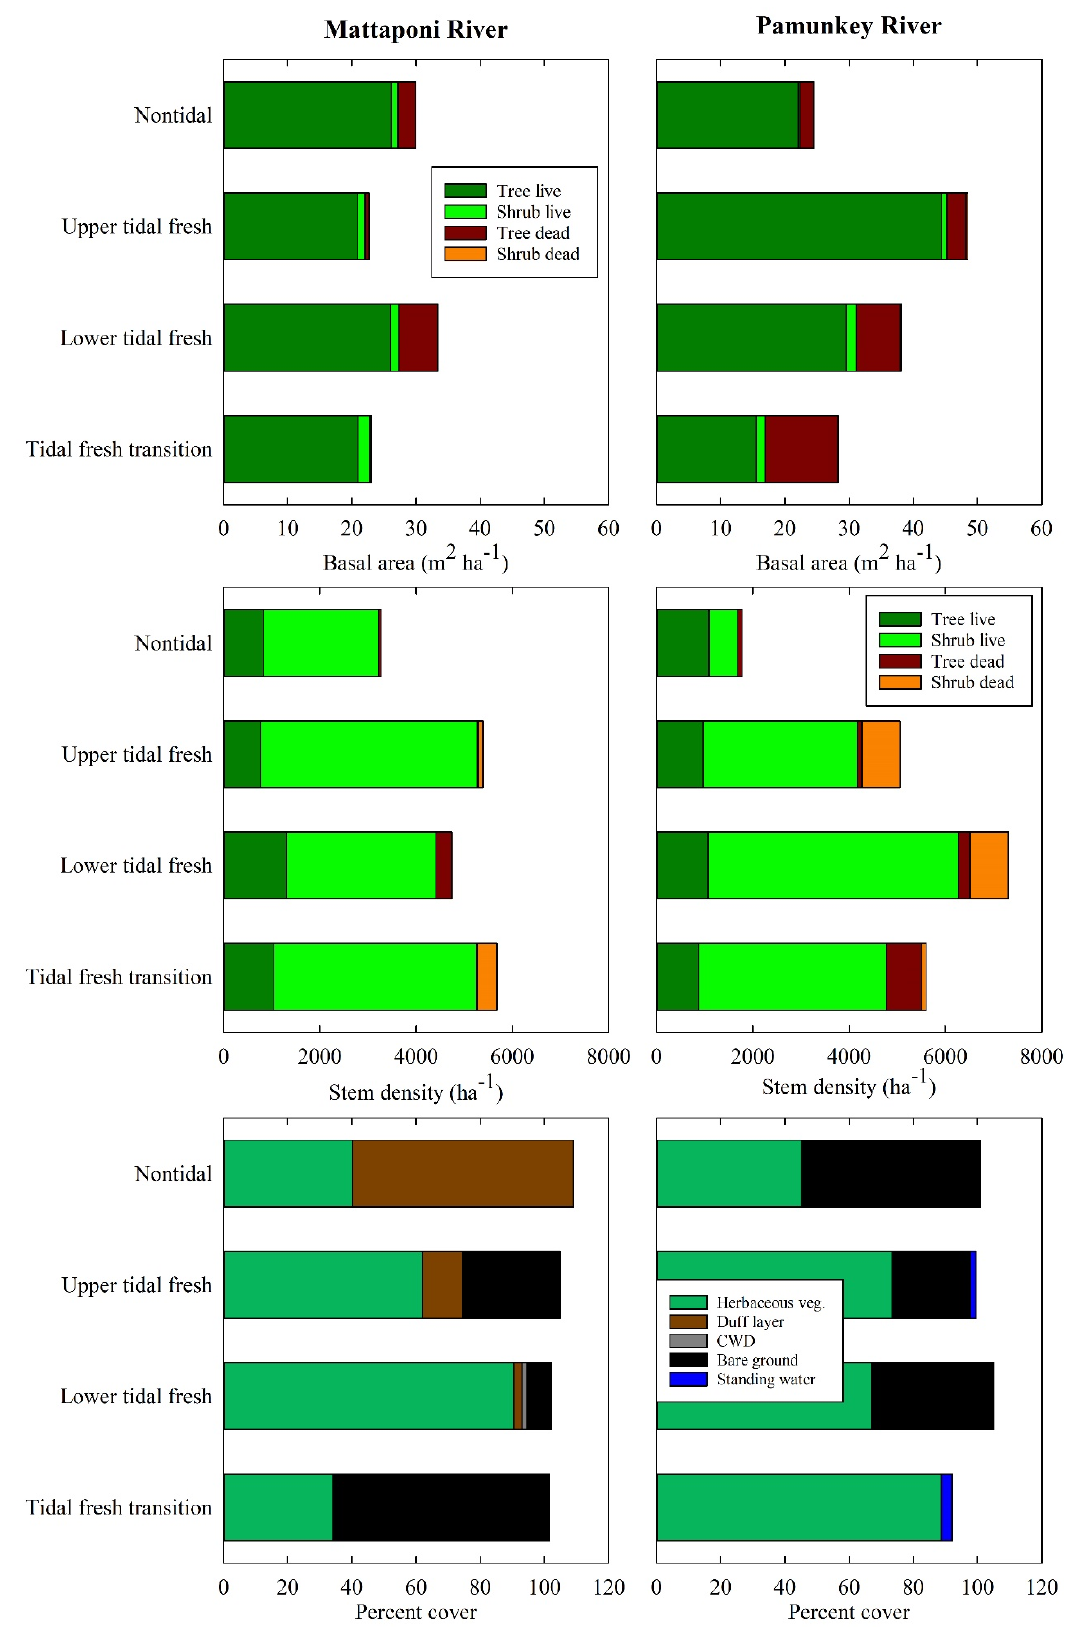
Figure 2. Mean basal area ( top ) and stem density ( middle ) for live and dead trees and shrubs, and percent herbaceous cover ( bottom ) at each of the study sites on the Mattaponi ( left ) and Pamunkey rivers ( right ) in 2016.